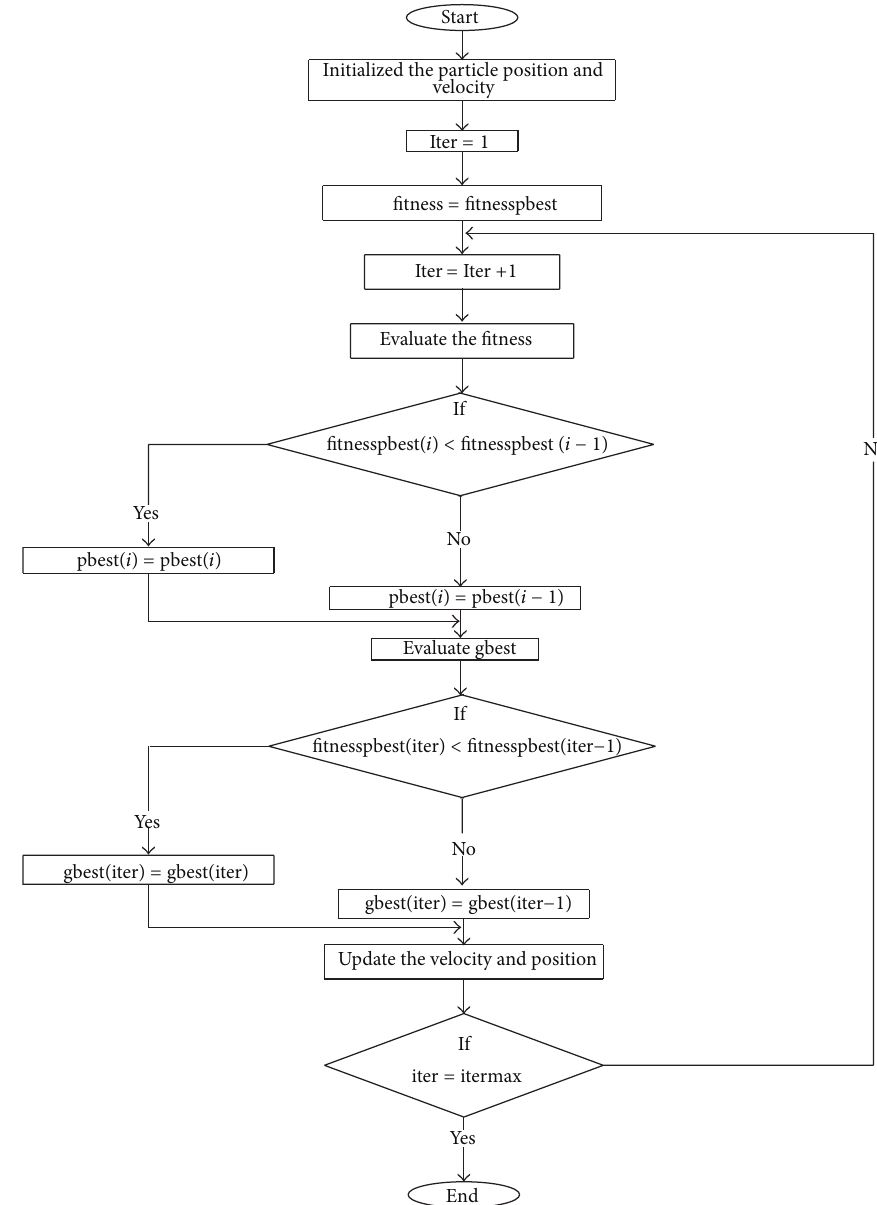
Figure 4: Flow diagram of basic PSO